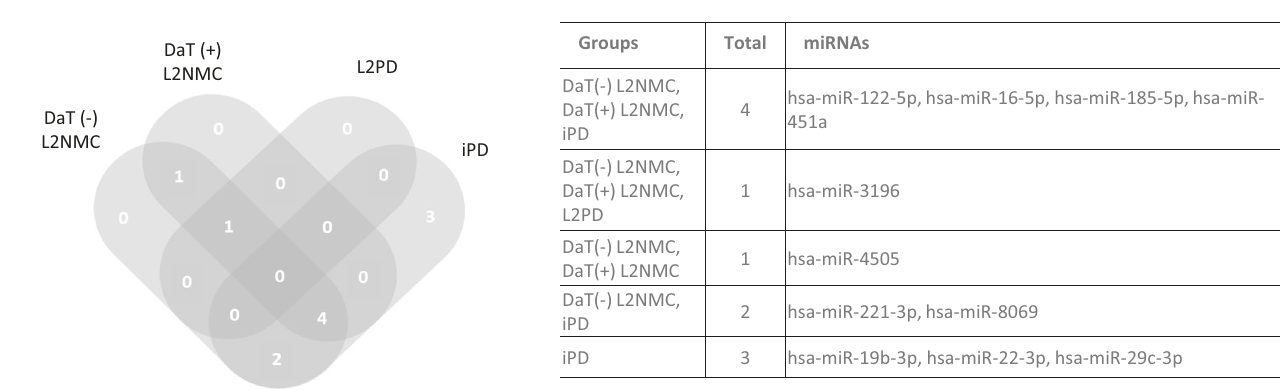
Fig. 2 Common and speci fi c candidate DEmiR of DaT-negative L2NMC, DaT-positive L2NMC, L2PD, and iPD as compared to controls. Venn diagram of a candidate DEmiR from the discovery analysis and b differentially expressed miRNAs (DEmiR) from the RT-qPCR miRNA assessment. DaT DaT-SPECT imaging, L2NMC LRRK2 non-manifesting carriers, L2PD LRRK2-associated PD patients, iPD idiopathic PD